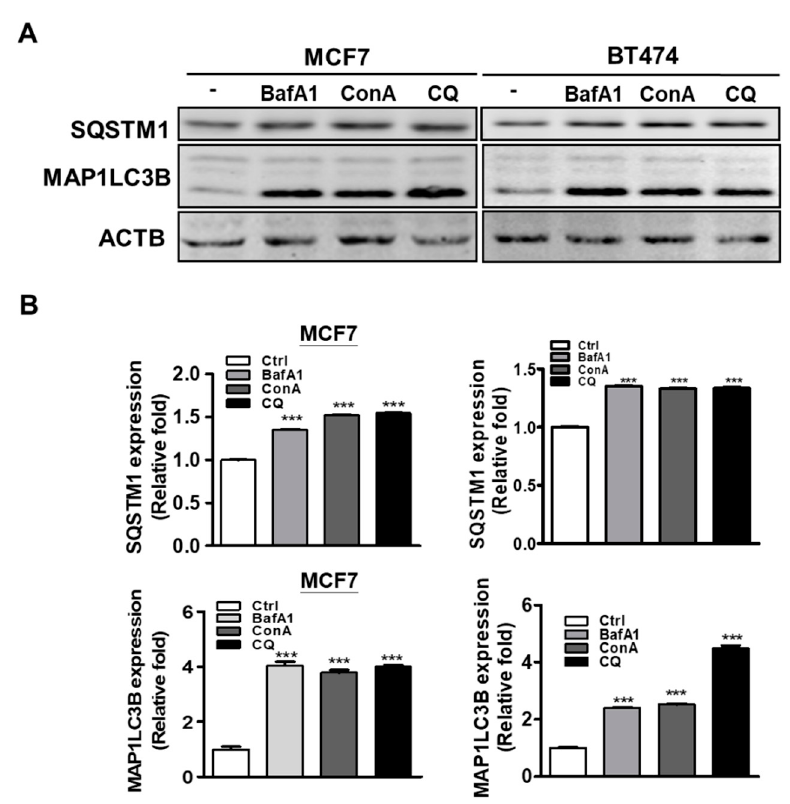
Figure 2. Effects of autophagy inhibitors on expressions of MAP1LC3B and SQSTM1 in breast cancer